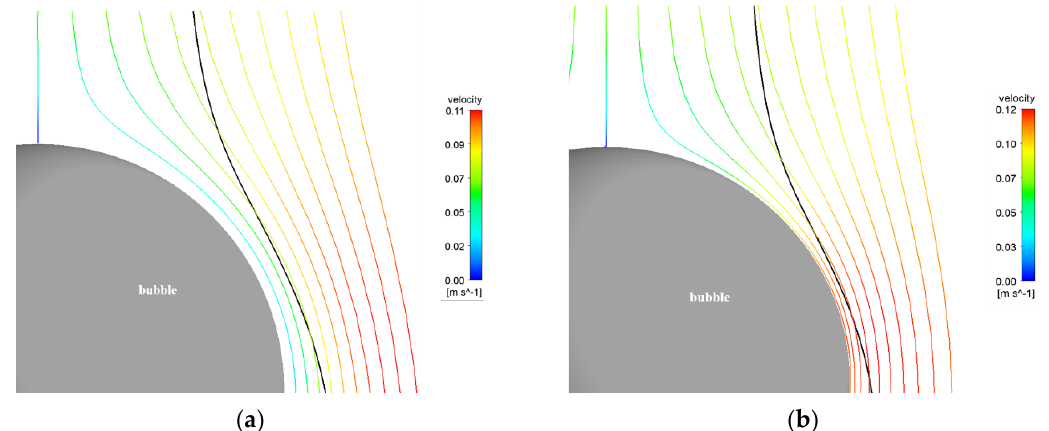
Figure 8. Particle tracks and mean streamlines for bubble diameter of 0.9 mm and galena particle diameter of 150 µ m ( a ), immobile surface; ( b ), mobile surface.